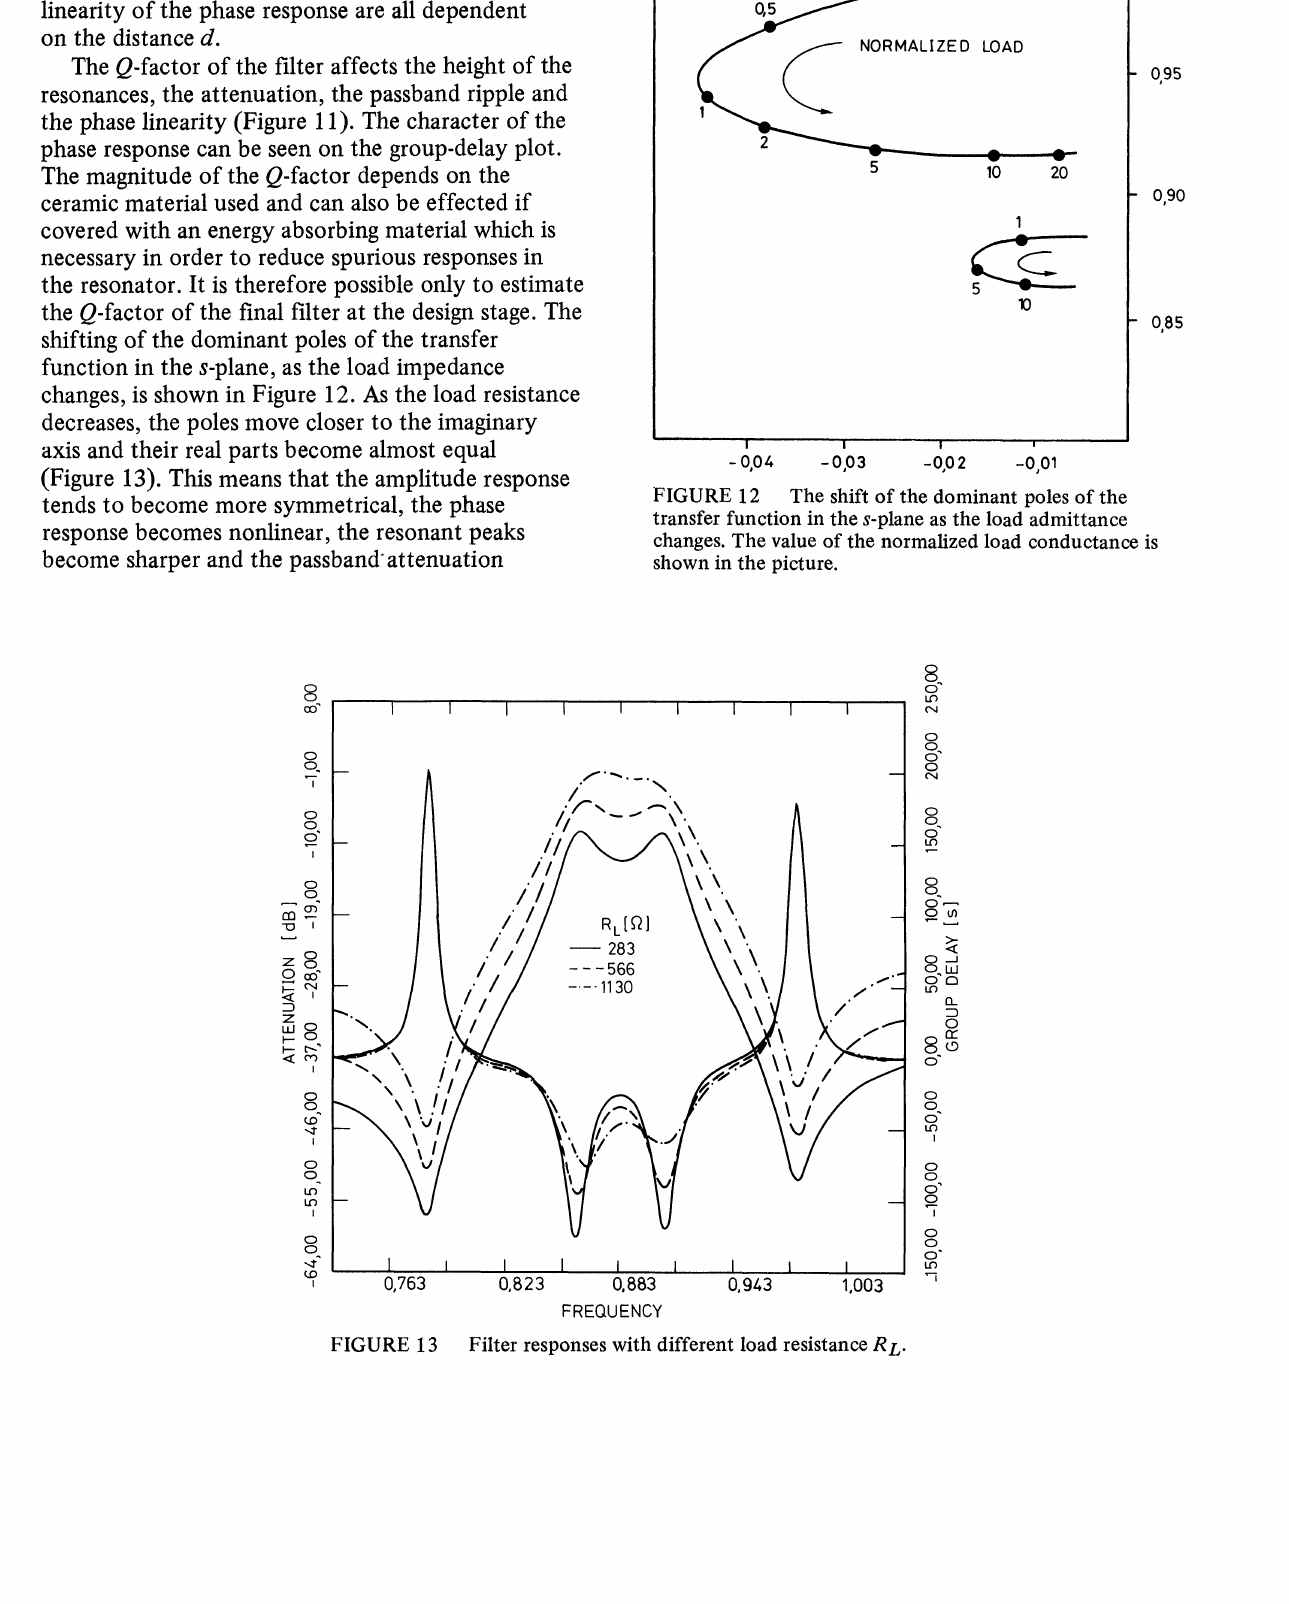
The shift of the dominant poles of the transfer function in the s-plane as the load admittance changes. The value of the normalized load conductance is shown in the picture.